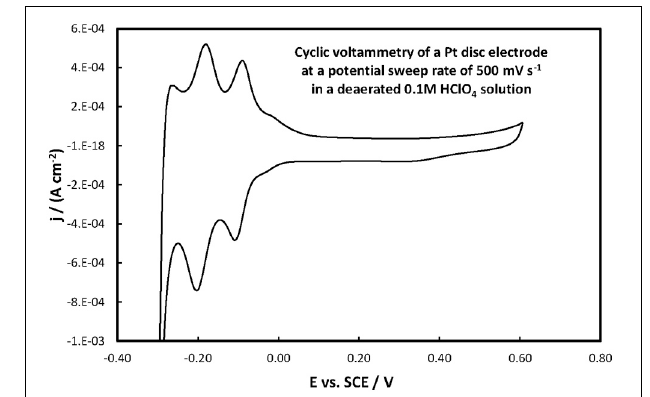
FIGURE 6 | Voltammograms of Pt(Ni)/GC and Pt-Ru(Ni)/GC electrodes (as indicated in the graph), in a deaerated 0.1M HClO 4 solution at 500mV s − 1 potential scan rate.